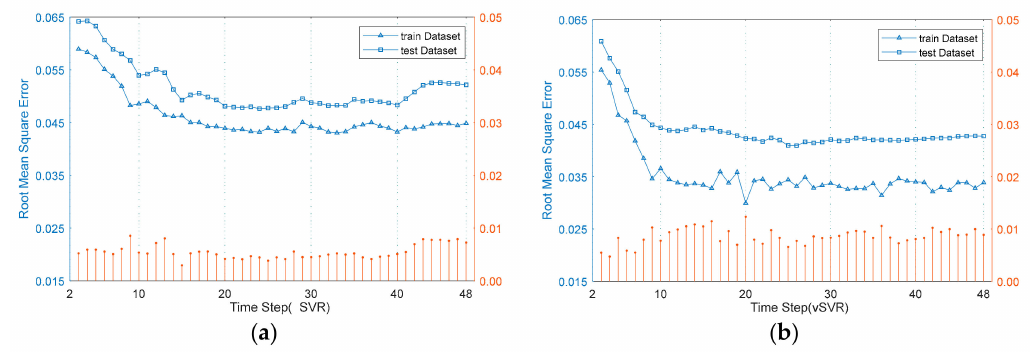
Figure 4. Root mean square error (RMSE) of v SVR and ε SVR when k gets di ff erent values. ( a ) The RMSE of v SVR; ( b ) The RMSE of ε SVR.